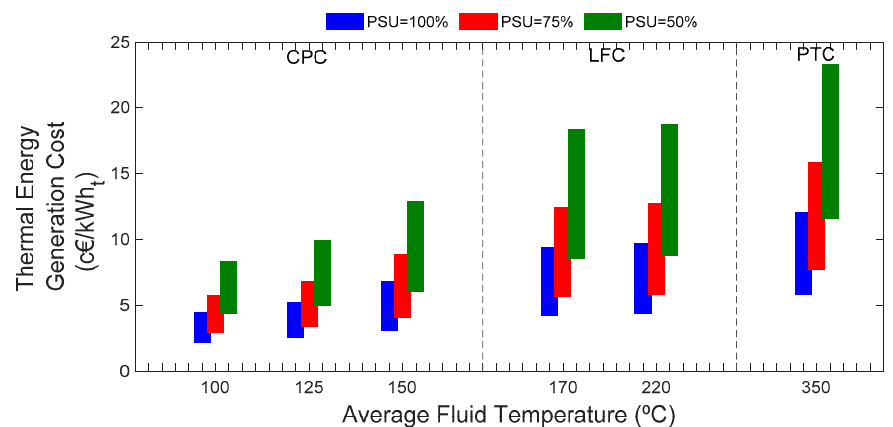
Figure 9. Thermal energy generation cost—Small size solar field area.